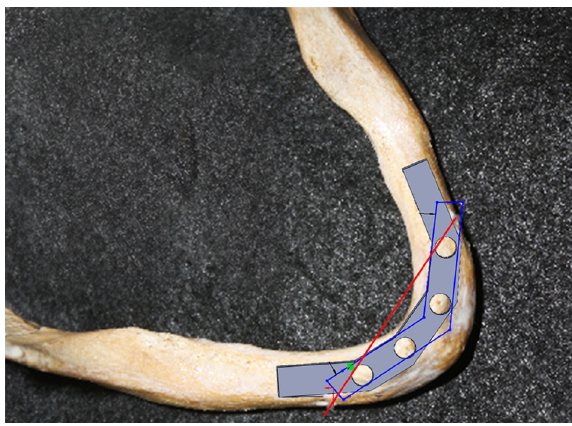
Figure 1. Interforaminal Distance (40.35mm) represented by red line. Tridimensional distribution. The blue line represents the contour of the matrix.